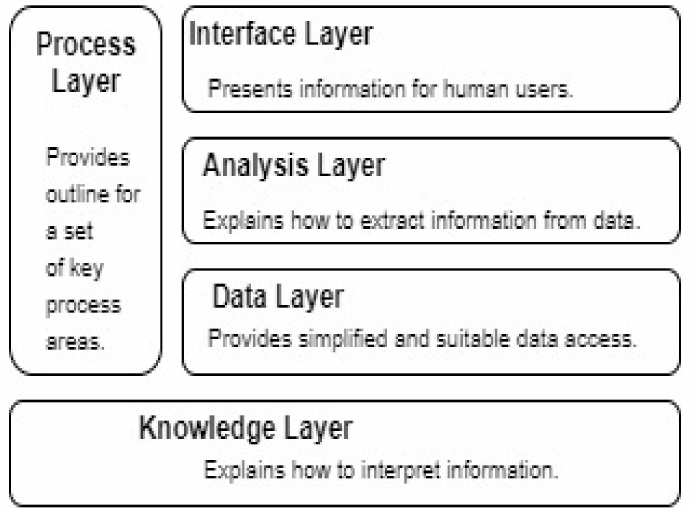
Figure 1. The multi-layered conceptual